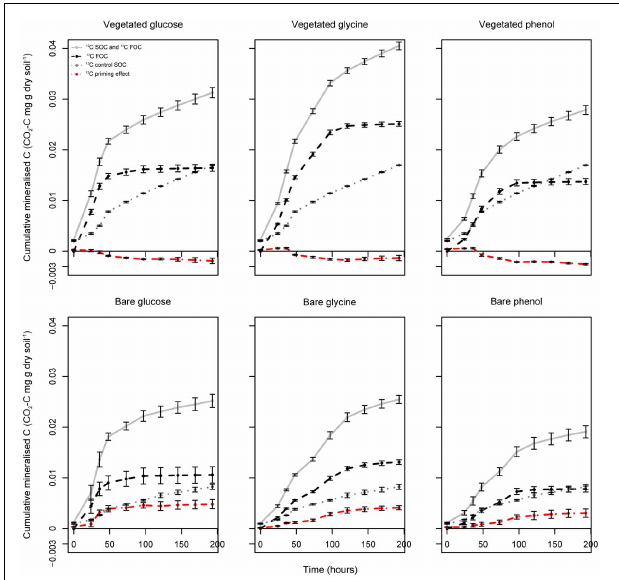
FIGURE 1 | Labeled FOC and unlabeled SOC turnover in vegetated and bare soils amended with labile 13 C substrates. Mean total respiration ( 12 C SOC and 13 C FOC), substrate-specific respiration ( 13 C FOC) and 12 C priming effects in vegetated and bare soils following the addition of 13 C-labeled glucose, glycine, and phenol. Priming effects were based on unlabeled SOC turnover rates after FOC addition, relative to 12 C SOC mineralization in the control soil. Error bars are SEM ( n = 3).